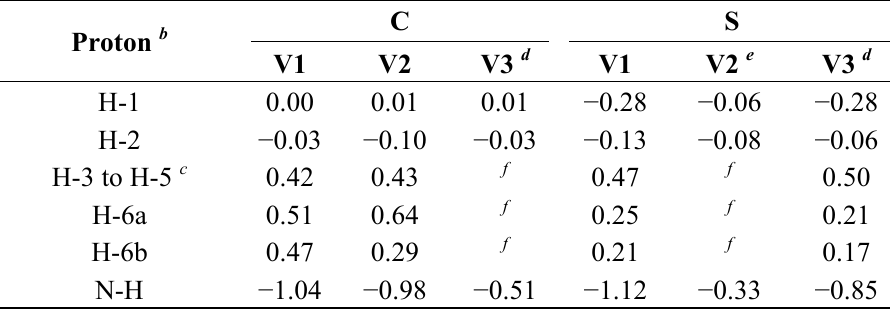
Table 2. Selected calculated CIS values (ppm) of receptor proton signals upon binding of viologens to S and C . a